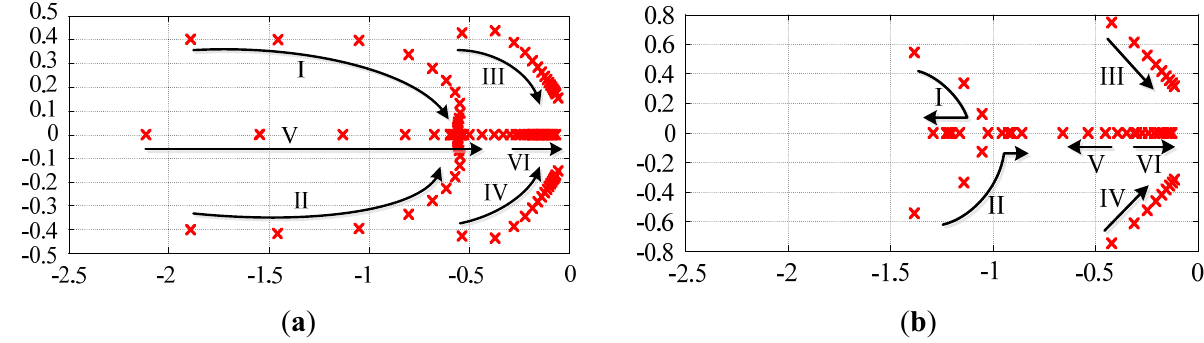
Figure 5. Closed-loop dominant poles for varying communication delay. ( a ) Mesh configuration ( b ) Radial